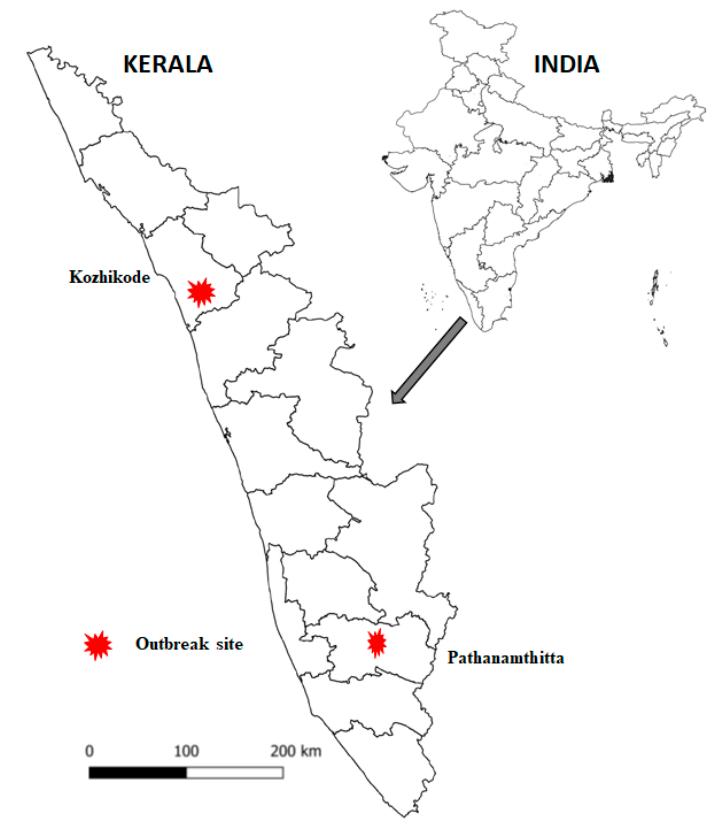
Figure 1. Map showing districts wherein cholera outbreak was reported in